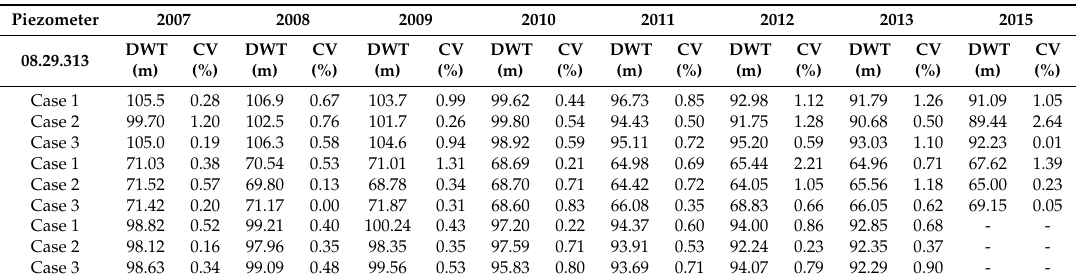
Table 4. Average dynamic water table (DWT) and coefficient of variation (CV) for each irrigation season and analyzed